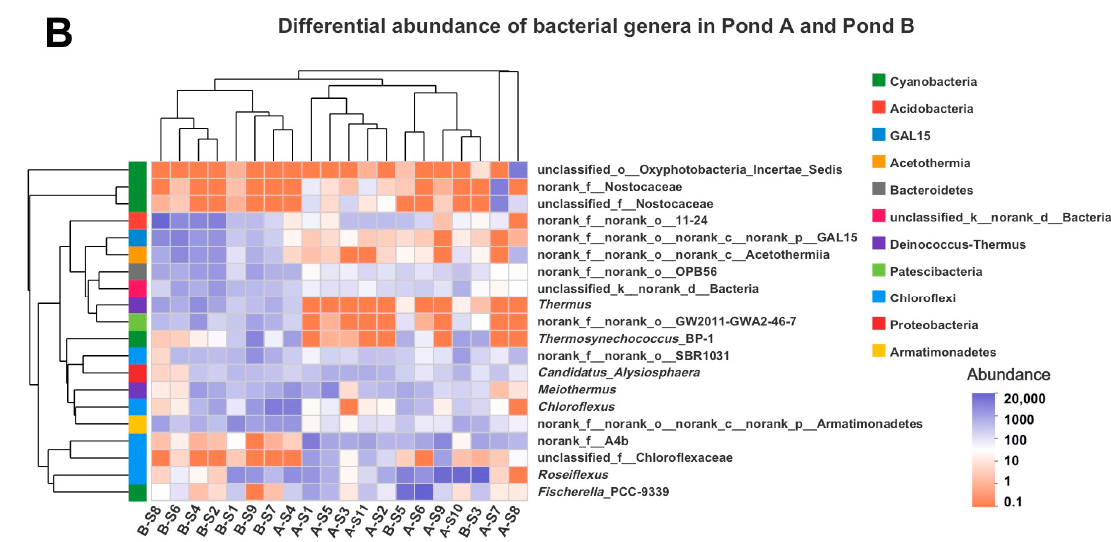
Figure 6. Heatmap of the top 20 abundant fungal ( A ) and bacterial ( B ) genera. Block color represents the abundance of different microbial genera. In the taxa names, “d” = domain, “k” = kingdom, “p” = phylum, “c” = class, “o” = order, and “f” = family.